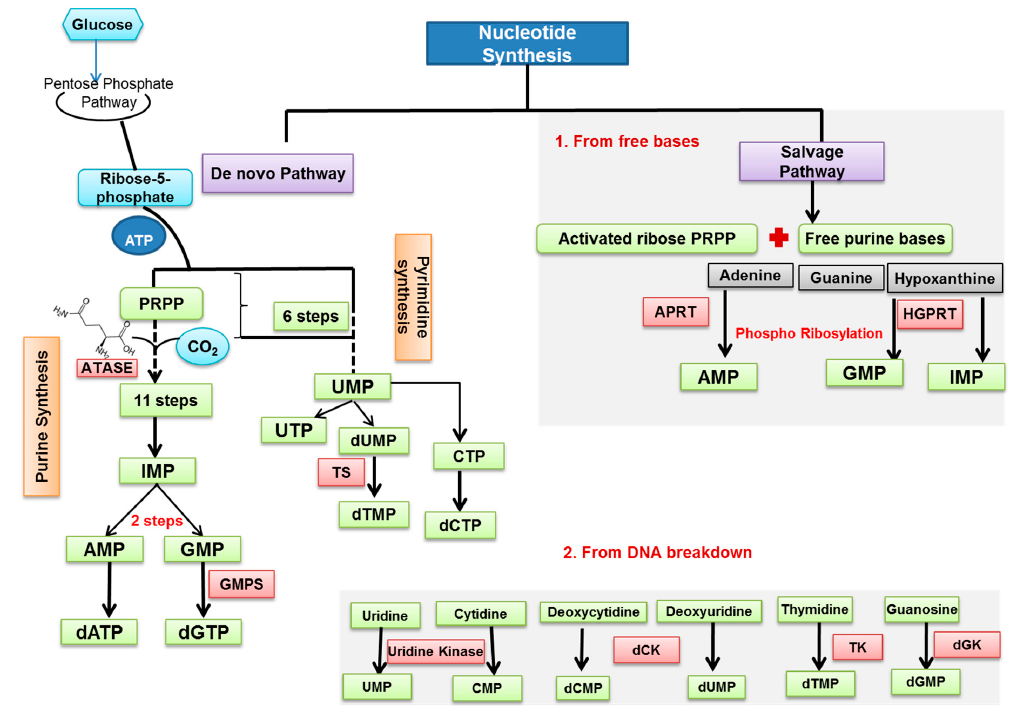
Figure 1. An overview of nucleotide synthesis. PRPP = 5-phospho ribosyl pyro phosphate; ATASE = amidophosphoribosyltransferase; IMP = inosine mono phosphate; AMP = adenosine mono phosphate; GMP = guanosine mono phosphate; CMP = cytidine mono phosphate; GMPS = guanosine mono phosphate synthetase; UMP = uridine mono phosphate; TS = thymidine synthetase; dATP = deoxyadenosine tri phosphate; dGTP = deoxyguanosine tri phosphate; dCTP = deoxycytosine tri phosphate; dTMP = deoxythymidine mono phosphate; APRT = adenine phosphoribosyl transferases; HGPRT = hypoxanthine-guanine phosphoribosyl transferases; dCK = deoxycytidine kinase; dGK = deoxyguanosine kinase. The dotted line represents the multiple steps.